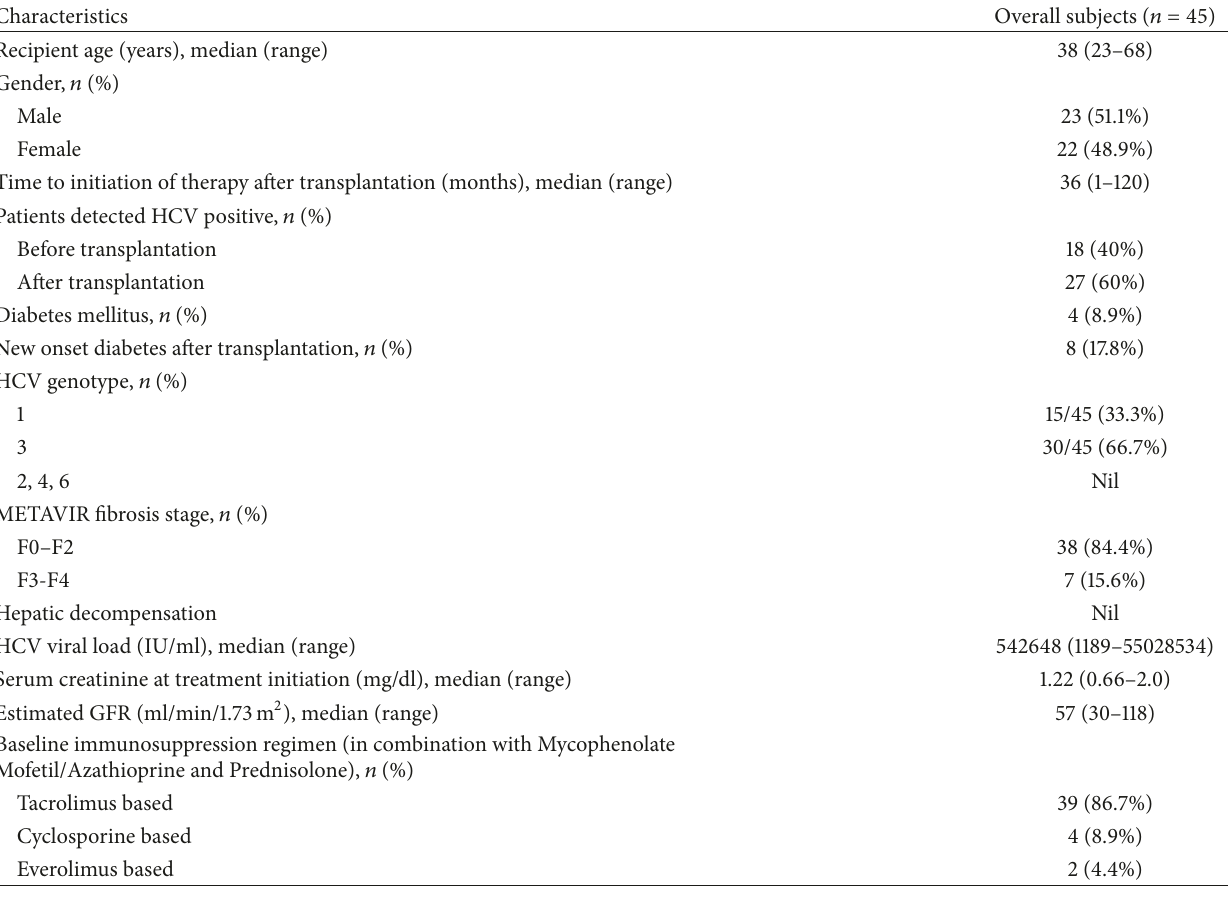
Table 2: Demographic and clinical characteristics at baseline.